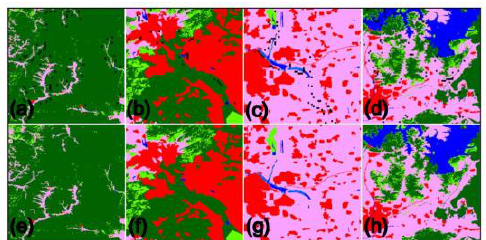
Figure 4. The underdetermined pixels among class map(fig. a, b, c, d were window based results, fig. e, f, g, h were window based results)